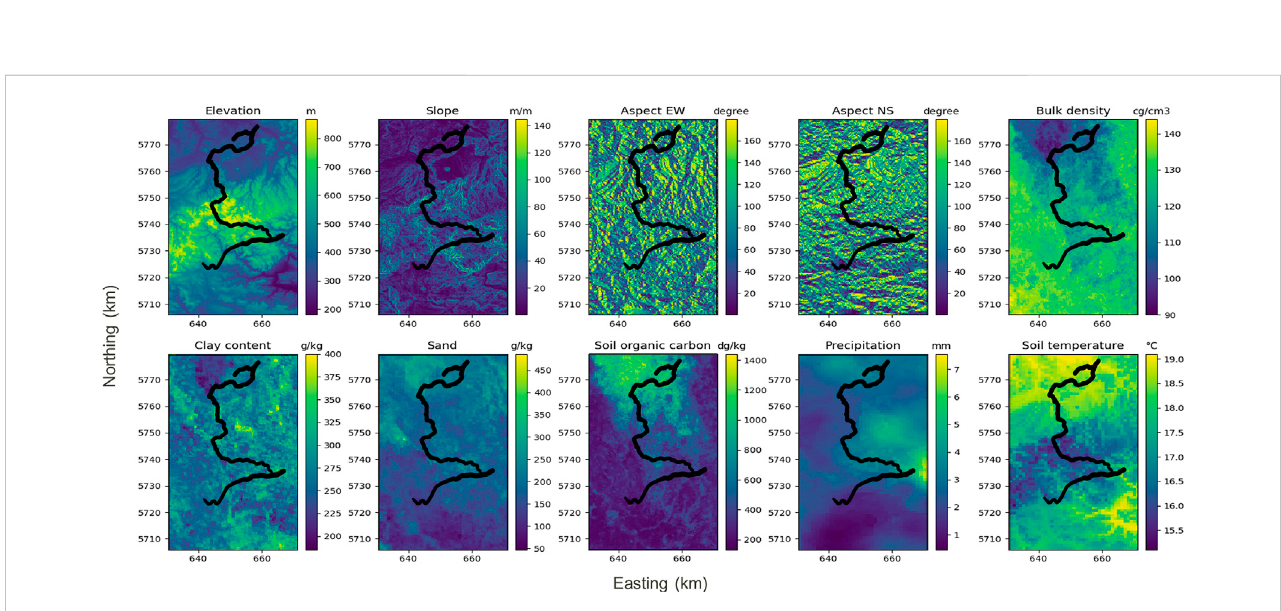
FIGURE 4 Features used in random forest for soil moisture